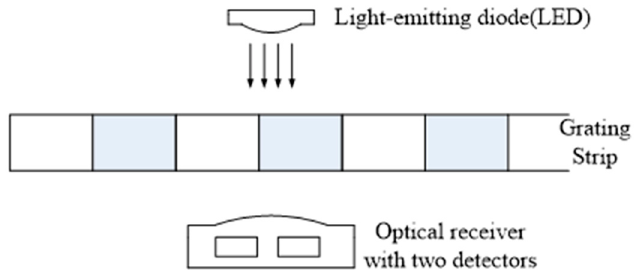
Figure 1. Displacement detection principle based on the grating strip.